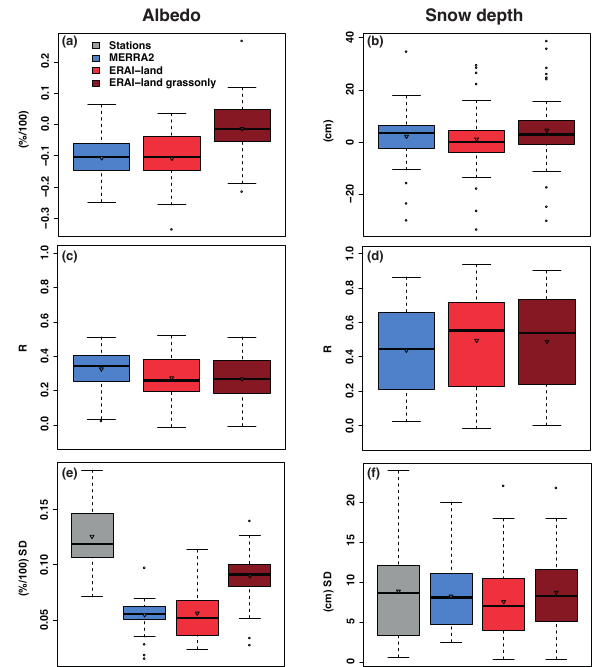
Figure 2. Box plot analysis for daily albedo (a, c, e) and snow depth (b, d, f) estimates using data from 44 locations over 2000–2013 MAMJ period. (a, b) Difference between station and reanalysis, (c, d) linear correlation between station and reanalysis, (e, f) standard deviation. Triangle indicates the mean